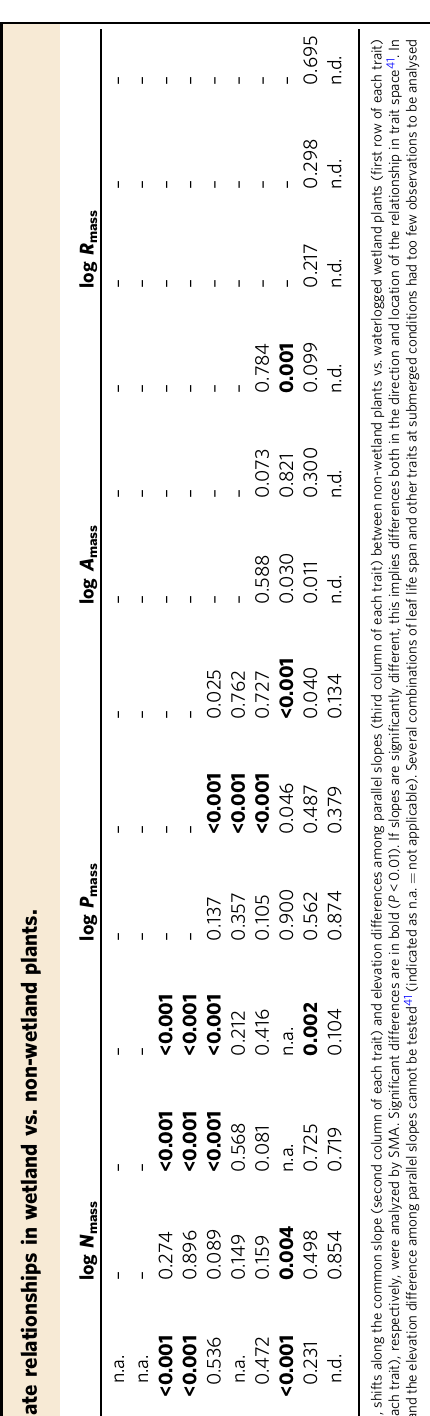
synthetic rate ( P < 0.01) (Fig. 2e – g). In combination, this suggests ferent for submerged plants than for non-wetland plants. For waterlogged wetland plants, the patterns of dark respira- tion rate were less apparent. For dark respiration rate vs. leaf N, we found no signi fi cant difference in the slopes ( P = 0.15), nor a shift along the common slope ( P = 0.06), nor elevation differences among parallel slopes ( P = 0.42) between the water- logged wetland plants and non-wetland plants (Fig. 2d). For leaf P, no signi fi cant slope ( P = 0.13) was observed, but waterlogged wetland plants showed a signi fi cant shift along the common slope towards higher dark respiration rate and leaf P values ( P < 0.001) (Fig. 2e). In both cases, the small sample size for dark respiration rate could have reduced the statistical power to detect differences in slope, and particularly in the case of dark respiration rate vs. leaf N the differences in slope was substantial (Supplementary Table 2). Also for dark respiration rate vs. LMA, a P -value of 0.03 in combination with the low sample size n = 11, suggested the presence of a different slope for wetland vs. non-wetland plants (Fig. 2f). Finally, for photosynthetic rate vs. dark respiration rate, no signi fi cant differences were observed for waterlogged vs. non- wetland plants (Fig. 2g). Bivariate trait relationships with leaf life span . How leaf traits co-vary with the leaf life span (LL) in submerged wetland plants remains uncertain, because of the limited number of data points ( n = 3 for LL-leaf N and LL-leaf P, and the absence of data linking LL-LMA, LL-photosynthetic rate and LL-dark respiration rate). For waterlogged wetland plants, we found a signi fi cant lower parallel slopes between LL-leaf N than non-wetland plants ( P < 0.01, Fig. 3a), suggesting that at a given leaf N, waterlogged wetland plants had a shorter leaf life span. We found no sig- ni fi cant differences in the relationships between leaf life span and other traits for waterlogged wetland plants ( P > 0.01, Fig. 3b – e). In summary, compared with non-wetland plants, signi fi cantly different slopes were detected in the relationship between leaf T